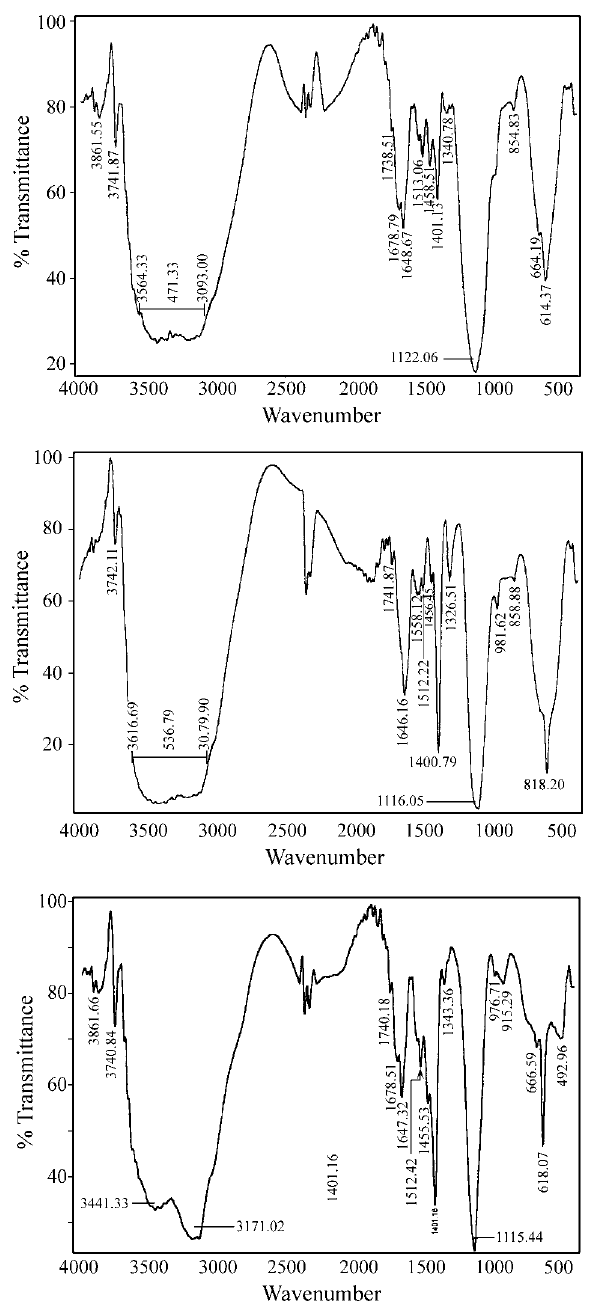
Figure 5c. Espectro IR característico de una disolución de Al 2 (SO 4 ) 3 0.1 molar, correspondientes a muestras líquidas obtenidas del filtrado del Figure 6. Espectros IR de fases sólidas obtenidas de la disolución